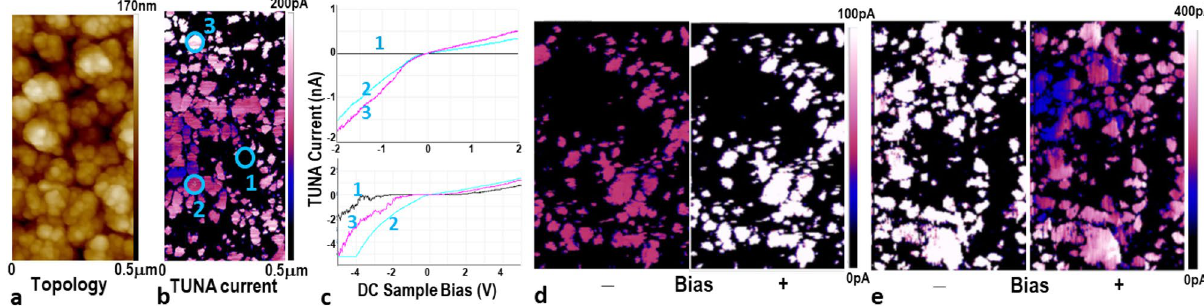
Figure 4. Micrographs of ( a ) AFM topology and ( b ) TUNA current with DC bias: 1 V in main scan, − 1 V in dark lift scan, mapping on same 0.5 µm 2 area of film S4; ( c ) I–V curves 1, 2, 3 obtained at spots 1, 2, 3 on AFM micrograph ( b ), for two ranges of negative and positive bias; vertical color scalebars ≡ photocurrent range. TUNA photocurrent mapping under positive and negative bias for ( d ) p- grains in S4( T) area and ( e ) n -grains in S4( B ) area; AC bias: 5 V in lift height: 100 nm.